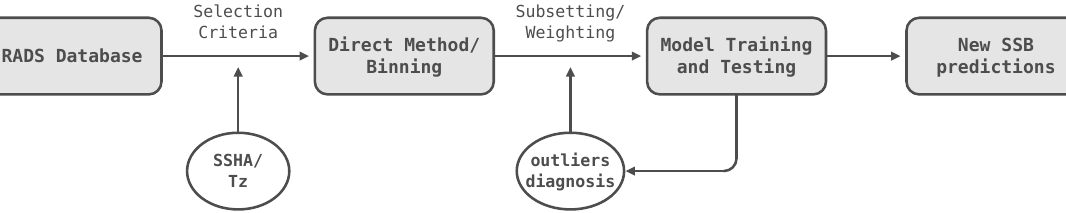
Figure 1. Flowchart diagram with the main steps of the model design. Starting on the left side, with altimetric data input, new parameters computation and selection criteria for binning procedure, and finishing on the right with strategies used for SSB modulation and